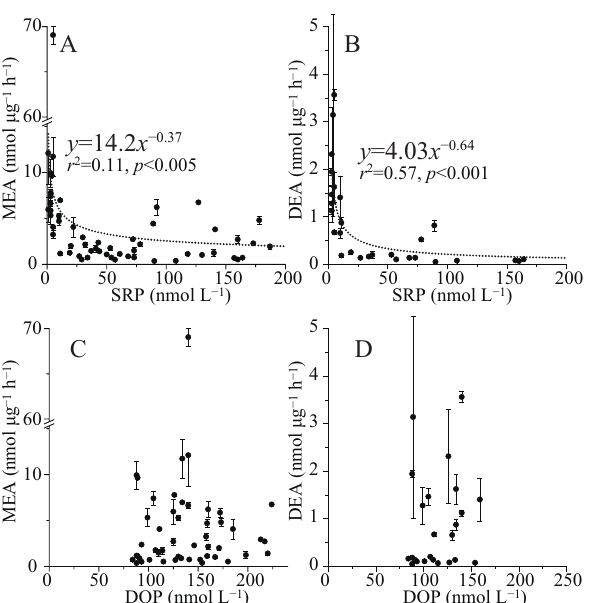
Fig. 5 Fig. 5. Chlorophyll a -normalized volumetric phosphate mo- noesterase (A, C) and diesterase (B, D) activities plotted against SRP (A, B) and total DOP (C, D) concentrations. Error bars indi- cate standard deviations of triplicate measurements.